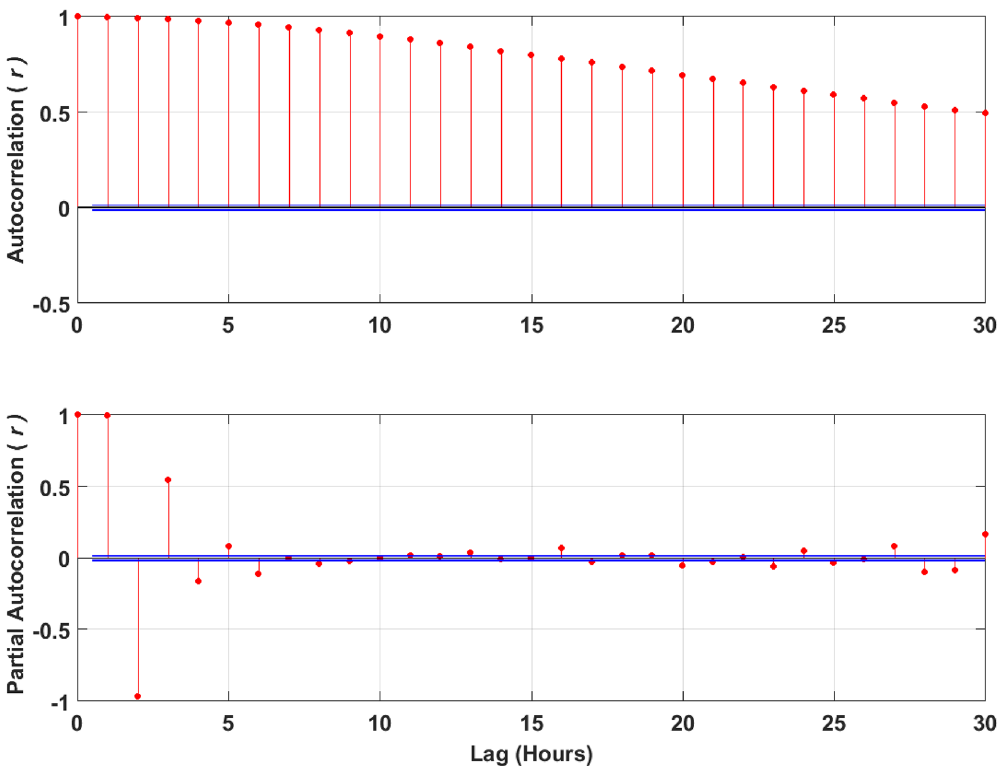
Figure 8. Autocorrelation (ACF) and partial autocorrelation (PACF) plot of the streamflow ( Q , m 3 s −1 ) time series for Brisbane river with lag in hours in order to make the input matrix of lagged streamflow series for the model input.